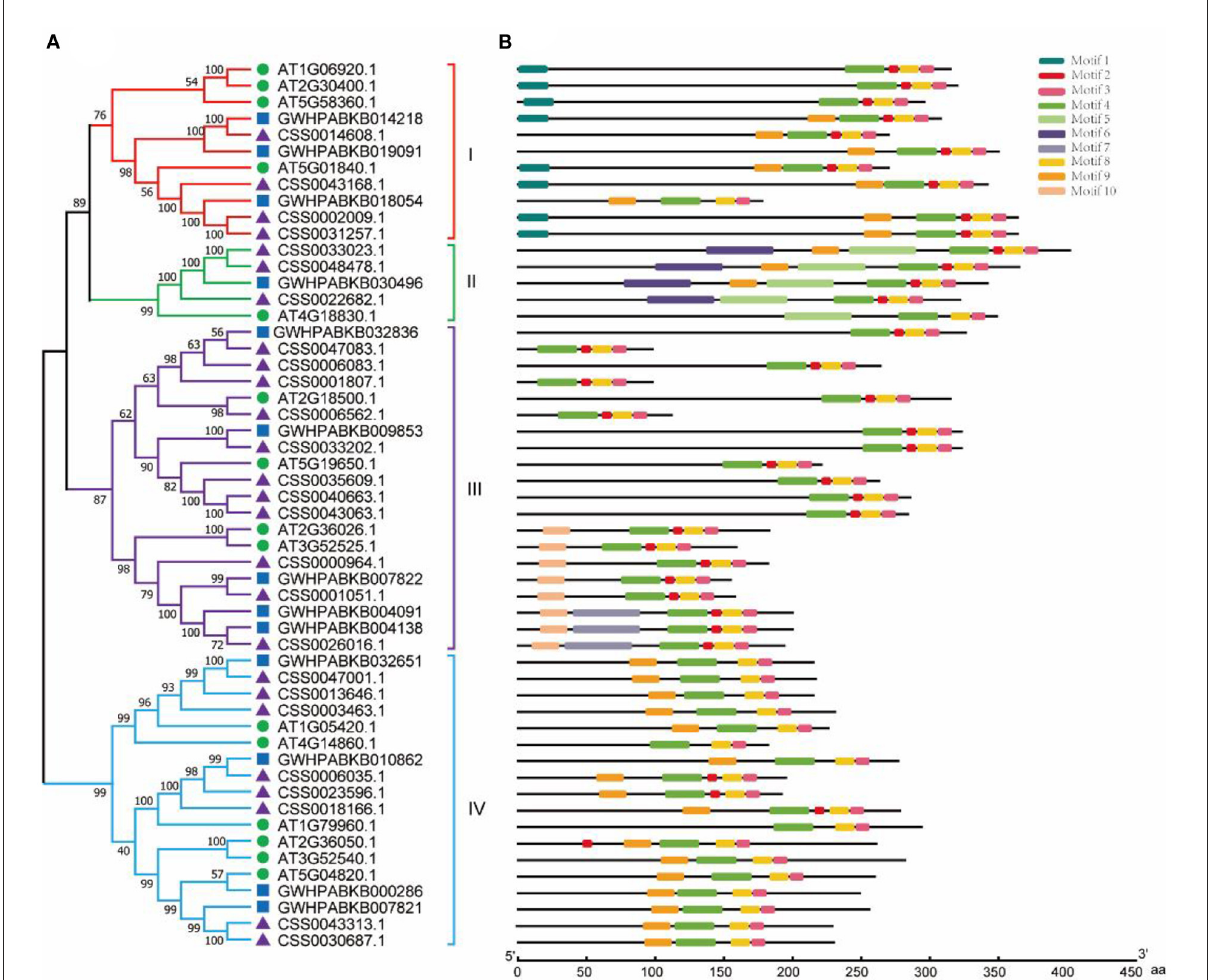
FIGURE2 Phylogenetic and structural analysis of OVATE proteins. (A) The phylogenetic tree of OVATE proteins from Arabidopsis thaliana and tea plant constructed using the neighbor-joining method. Green circle, blue square and purple triangle represent Arabidopsis thaliana , ancient tea tree (“DASZ”) and cultivated tea tree (“ShuChaZao”) respectively. (B) Protein motifs of